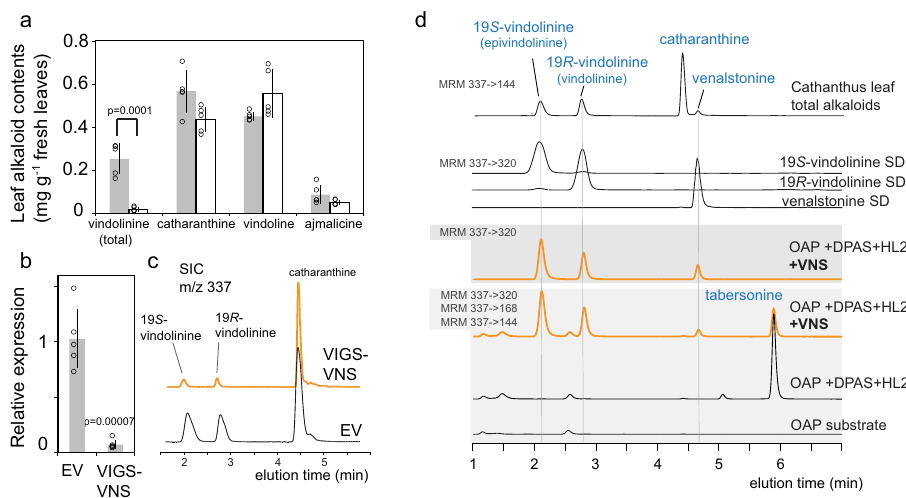
Fig. 2 Vindolinine synthase (VNS) is responsible for the biosynthesis of 19 S/R -vindolinine and venalstonine in vivo and in vitro. a Virus-induced gene silencing (VIGS) resulted in 95% reduction in the levels of the 19 R -vindolinine and 19 S -vindolinine in C. roseus leaf compared to the empty vector (EV) controls. b In the VIGS plants, the VNS transcripts were reduced by 93% compared to the EV controls. c Representative LC-MS chromatogram showing the reduction of vindolinine 19-epimers in VIGS plants ( m/z 337). d Tabersonine was biosynthesized when O -acetylprecondylocarpine (OAP) is incubated with dihydroprecondylocarpine acetate synthase (DPAS) plus Hydrolase 2 (HL2) recombinant enzymes. Addition of VNS to DPAS and HL2 recombinant enzymes converted OAP to 19 R -vindolinine, 19 S -vindolinine, and venalstonine at the expense of tabersonine. The following multiple reaction monitoring (MRM) ion transitions were used for detection: m/z 337->320 (vindolinine 19-epimers and venalstonine); m/z 337->144 (catharanthine, vindolinine 19- epimers, and venalstonine); m/z 337->168 (tabersonine). The alkaloid MS spectra used for selecting these parameters are found in Supplementary fi gure 3. In VIGS experiments, the data was generated by taking the mean values from 5 VIGS and 5 EV control plants. The error bars indicate the standard deviation. Unpaired two-tailed Student ’ s t -test was used for statistical analyses in VIGS experiments. For total vindolinine, the p value was 0.0001; for catharanthine, the p value was 0.0373; for vindoline, the p value was 0.0756; for ajmalicine, the p value was 0.110. The p value for relative VNS expression between EV and VIGS plants was 0.00007. Table 1 Vindolinine synthase (VNS) requires both α -ketoglutarate and ascorbate for activity in vitro. α -keto-glutarate (mM)